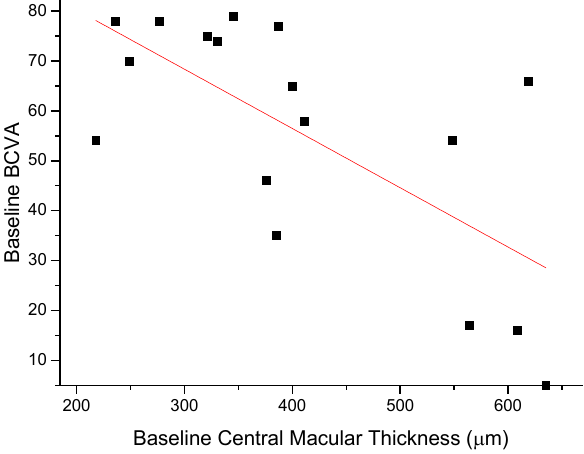
Figure 3. Baseline BCVA was negatively correlated with CMT (r = − 0.5, p < 0.05).